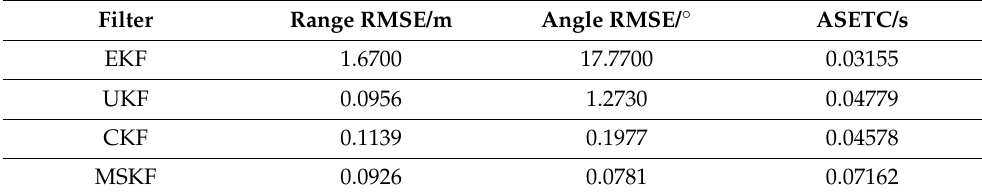
Table 1. Different filtering accuracy and time consumption in scenario (1).